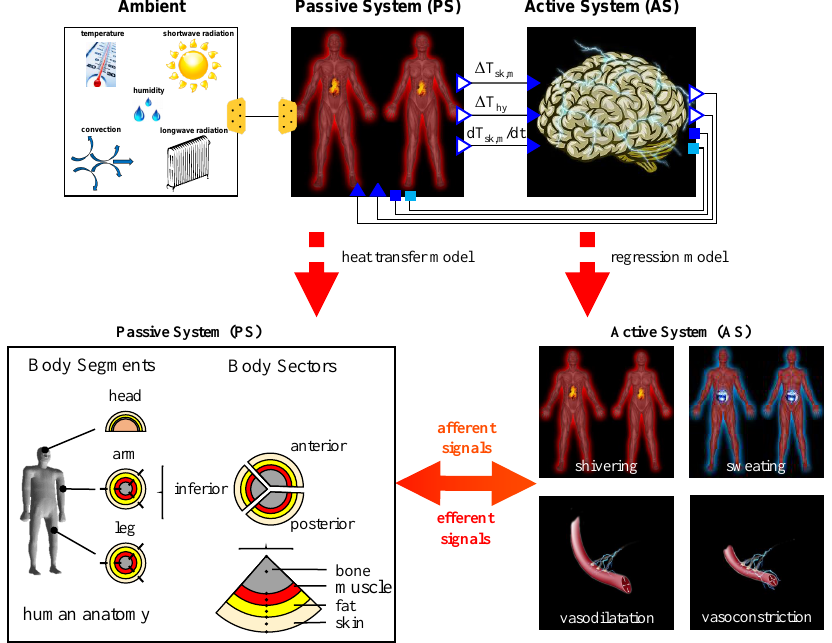
Figure 2. Schematic of the numerical human model MORPHEUS, which consists of an Ambient model, an Active System (AS) and a Passive System (PS) component